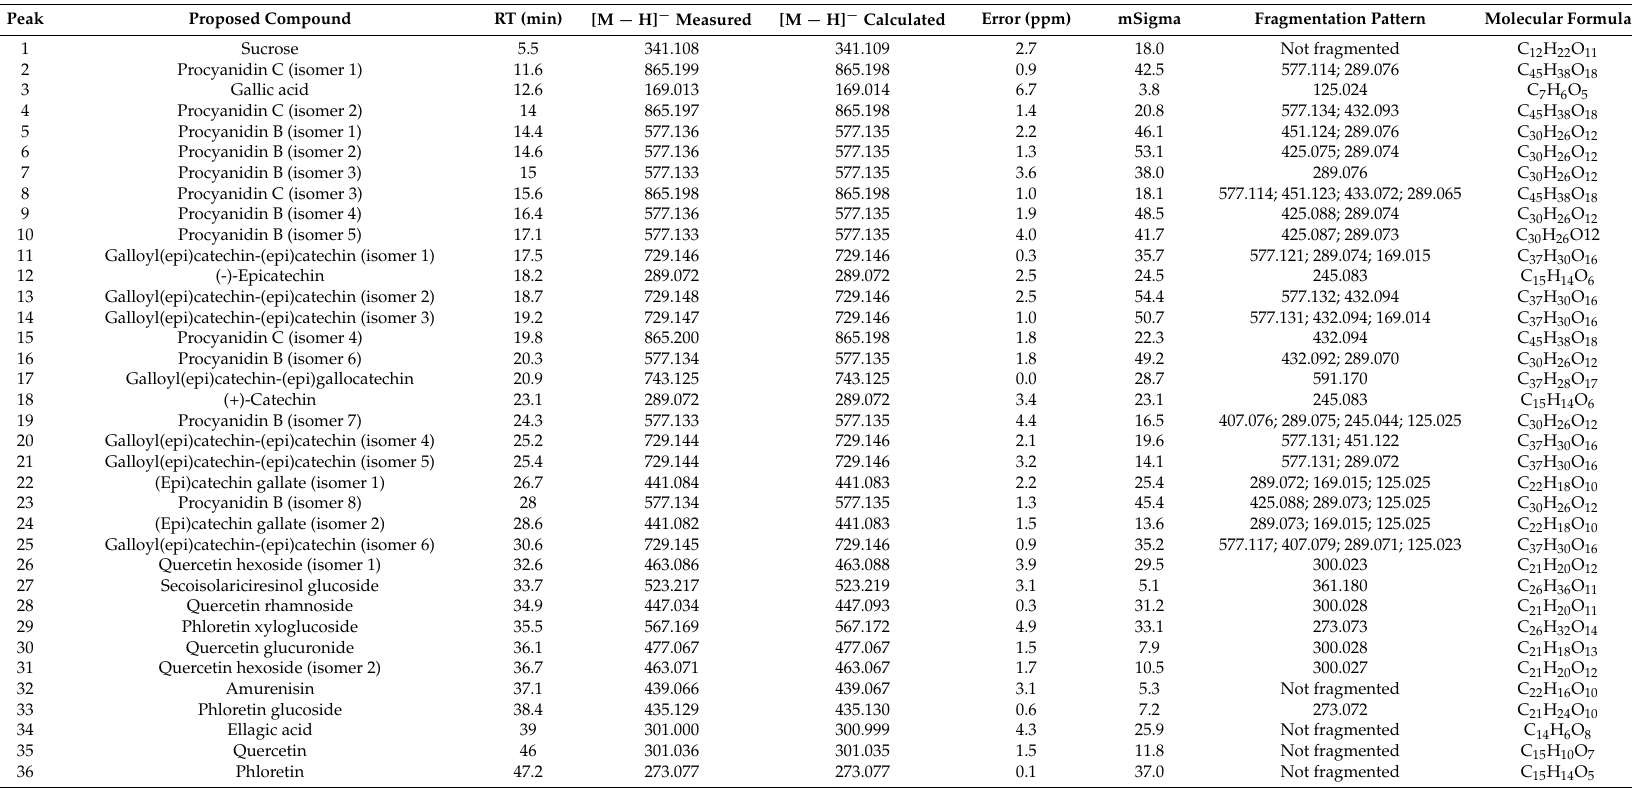
Table 1. Retention time and mass spectral data of the compounds characterized in grape seed extract by HPLC-ESI-QTOF-MS and MS/MS in negative mode.